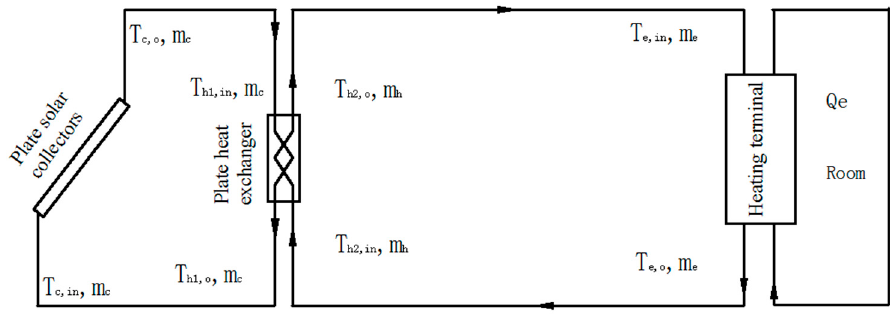
Figure 9. Operation model of the direct supply of heat from the solar collector to the room.